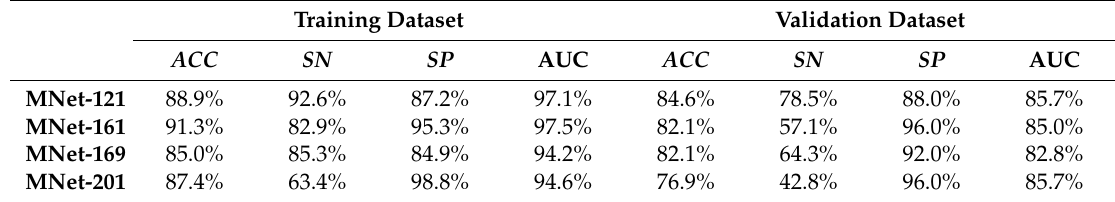
Table 3. Isocitrate dehydrogenase genotype prediction performance.